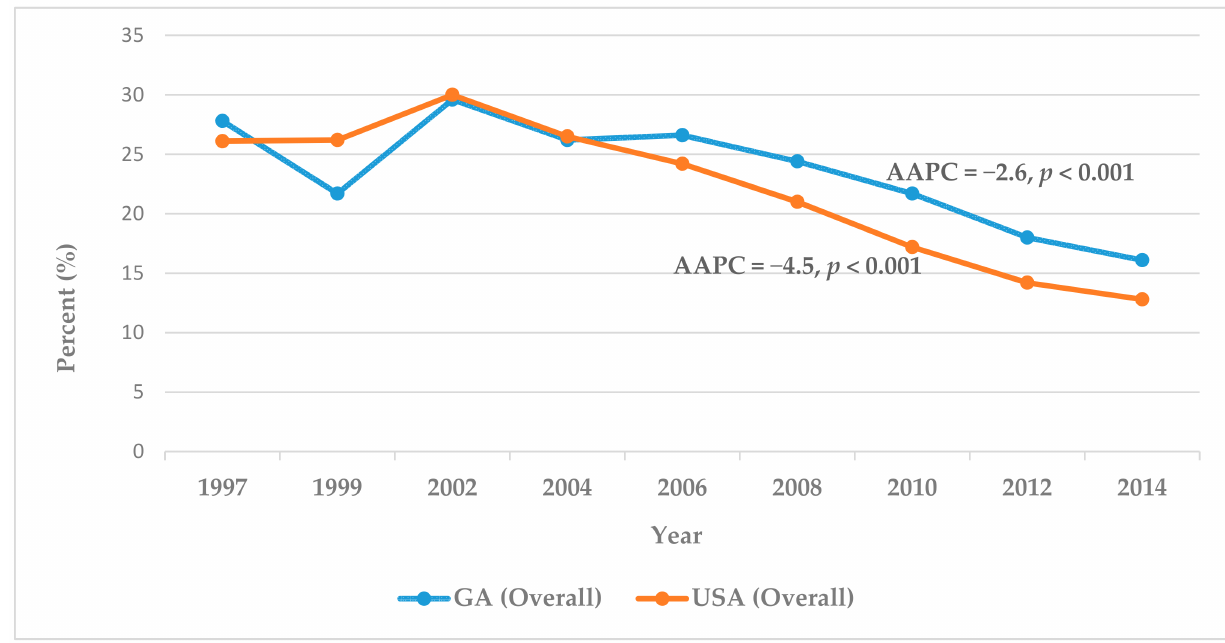
Figure 1. Adults aged 50+ who have had a blood stool test within the past two